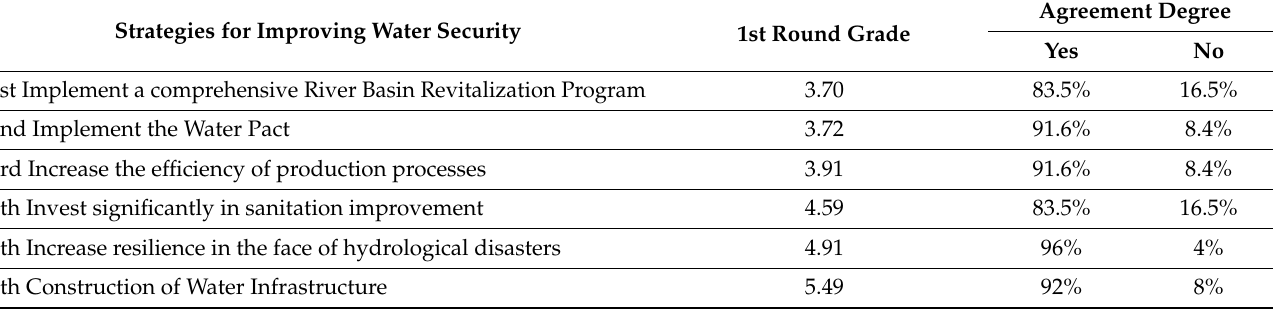
Table 2. Agreement degree bands displayed by the strategies in the first round of the Delphi method ( n = 26). Strategies for Improving Water Security 1st Round Grade